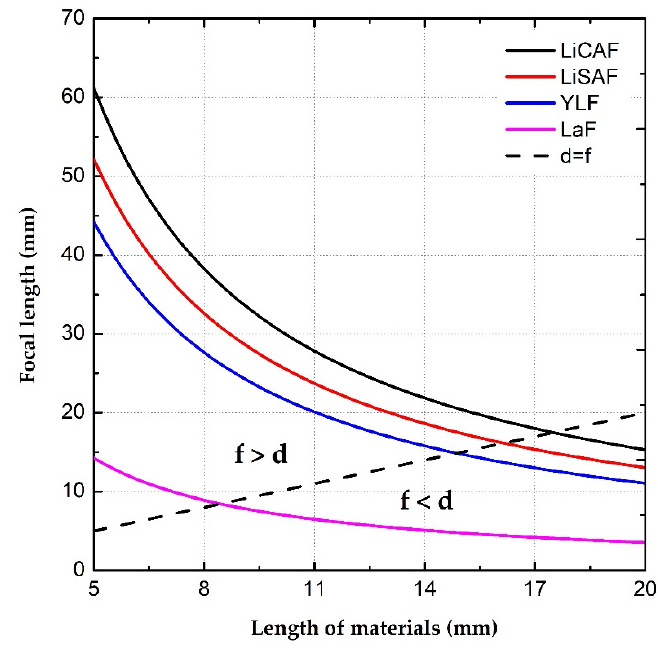
Figure 5. Focal length as a function of the length of the laser host material. The dashed line indicates the condition when the focal length of self-focusing is equal to the length of the laser material ( f = d ).